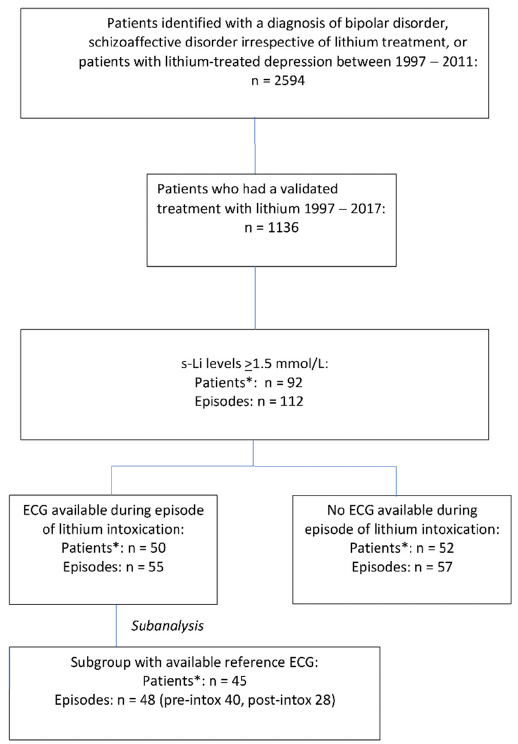
Figure 1. Selection of study sample. n: number. * Some patients had more than one episode of lithium